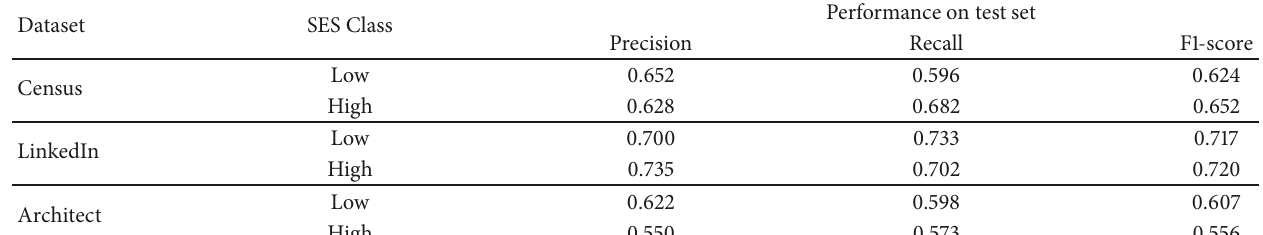
Table 3: Detailed average performance (5-CV) on test data for the binary SES inference problem for each of the 3 datasets.